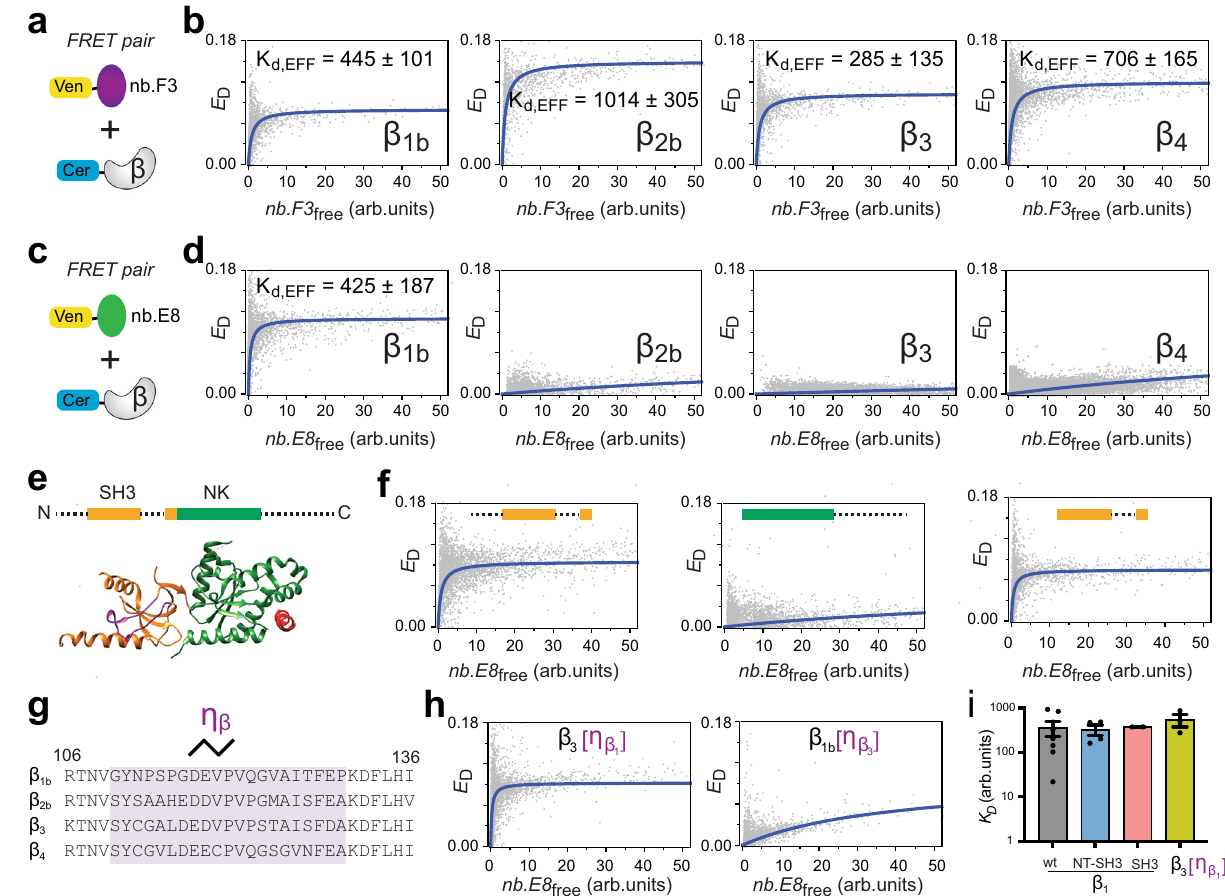
Fig. 2 | Identi fi cation of nb.E8 as a Ca V β 1 -selective nanobody. a Schematic of fl uorescence resonance energy transfer (FRET) pair, Venus-nb.F3 + Cerulean-Ca b Flow cytometry FRET ( fl ow-FRET) scatter plots with FRET ef fi ciency ( E D ) plotted vs free nb.F3 concentration. The blue lines fi t a 1:1 binding model to the data. Data show nb.F3 binds all four Ca V β subunit isoforms. K d,EFF , effective dissociation constant. c Schematic of Venus-nb.E8 + Cerulean-Ca V β . d Flow-FRET scatter plots and binding curves show nb.E8 exclusively binds Ca V β 1 . e Top , schematic of Ca V β structural organization. Conserved src homology 3 (SH3, orange) and nucleotide kinase (NK, green) domains are bounded by variable N- and C-termini, and sepa- rated by a HOOK domain. Bottom, cryoEM structure of Ca V β 1a (PDB: 5GJV). f Flow-